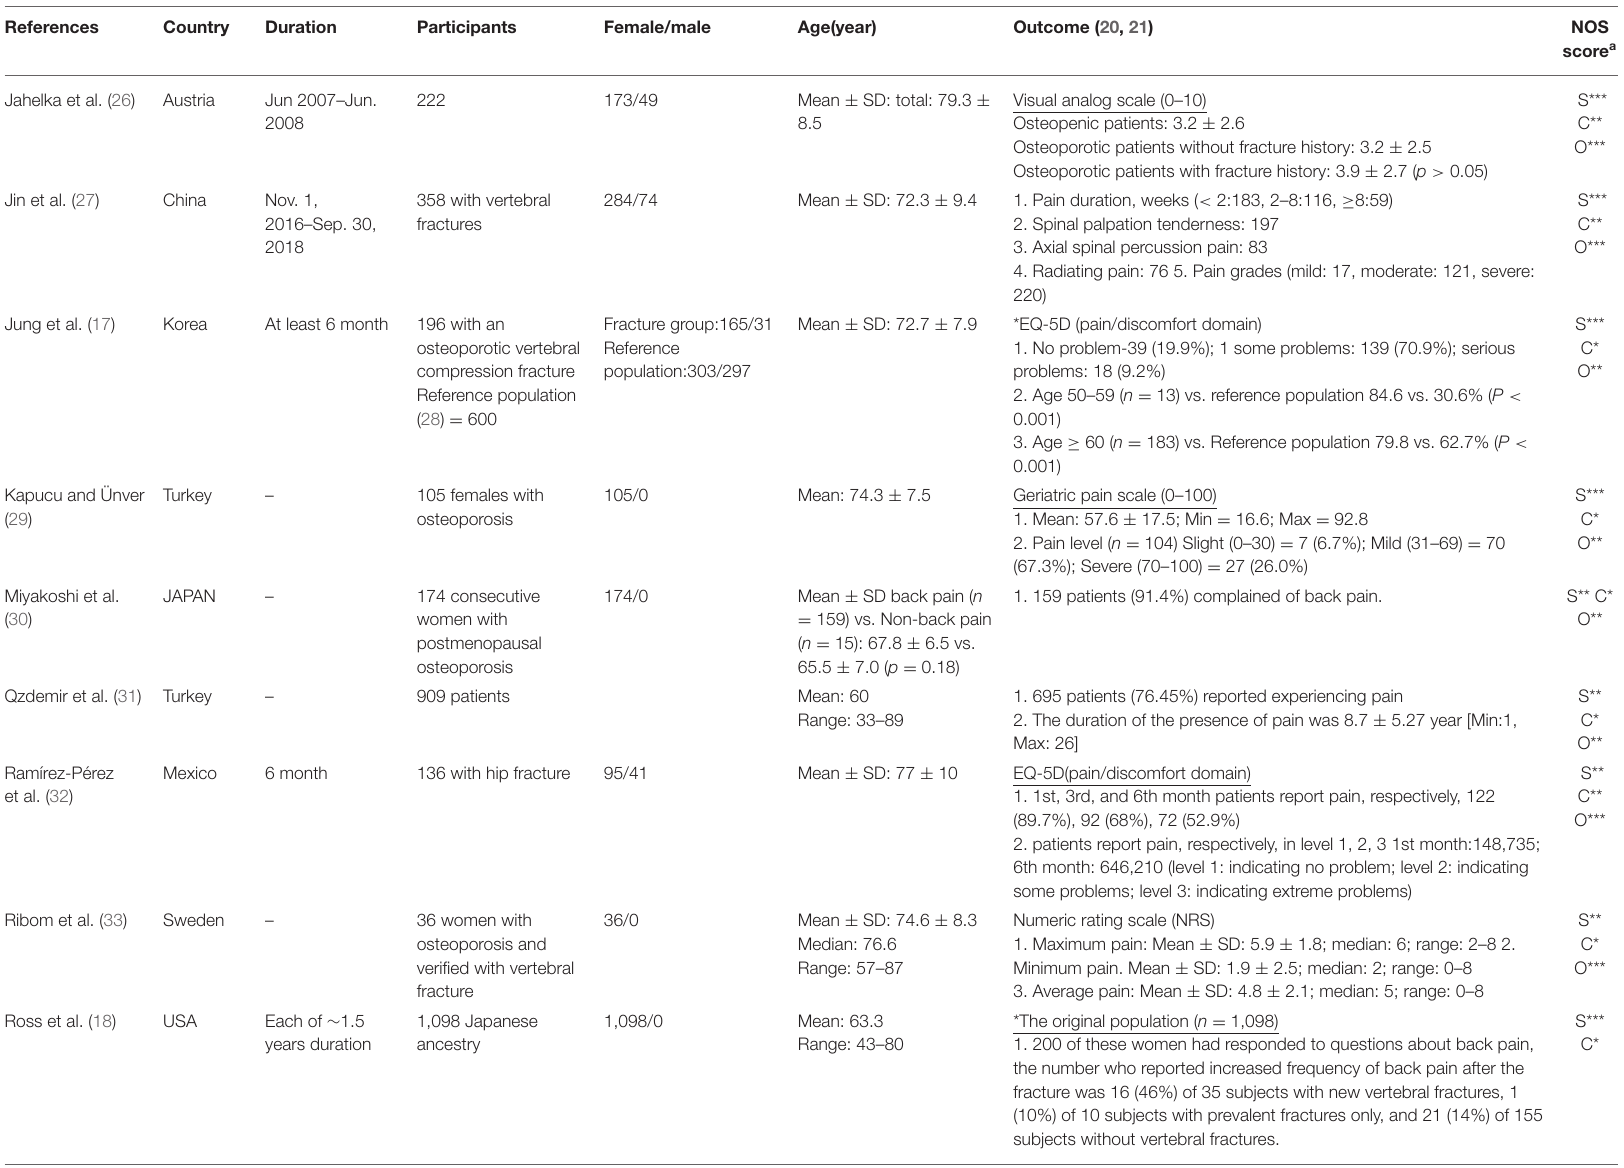
1. Pain duration, weeks ( < 2:183, 2–8:116, ≥ 8:59) 2. Spinal palpation tenderness: 197 3. Axial spinal percussion pain: 83 4. Radiating pain: 76 5. Pain grades (mild: 17, moderate: 121, severe: